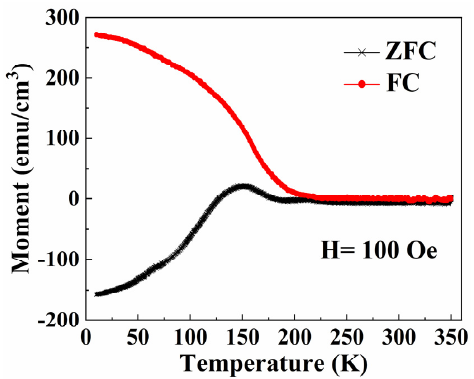
Figure 2. The M(T) data after ZFC and FC processes for PSMO-7 film on SrTiO 3 under the applied magnetic fields of 100 Oe.